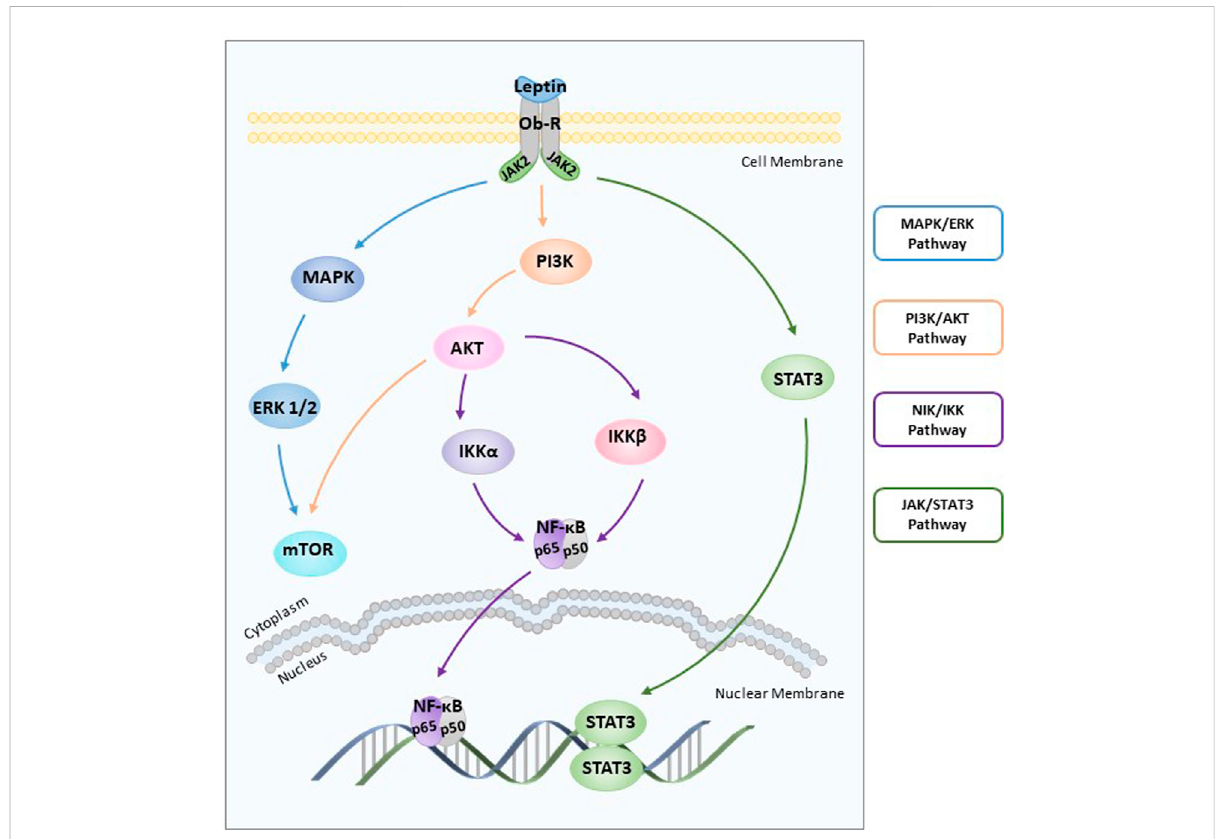
FIGURE 1 Role of leptin in endometrial cancer. Leptin induces two key cell-growth signalling pathways (ERK and AKT) after rapidly activating the JAK/ STAT3 pathway. Leptin-induced NF- κ B activation inhibits cancer cell apoptosis through the NIK/IKK signalling pathway. ERK: extracellular signal- regulated kinase; AKT: the serine/threonine kinase; JAK: janus-activated kinase; STAT3: signal transducers and activators of transcription 3; NIK: nuclear factor-kappa B inducing kinase; IKK: IKB